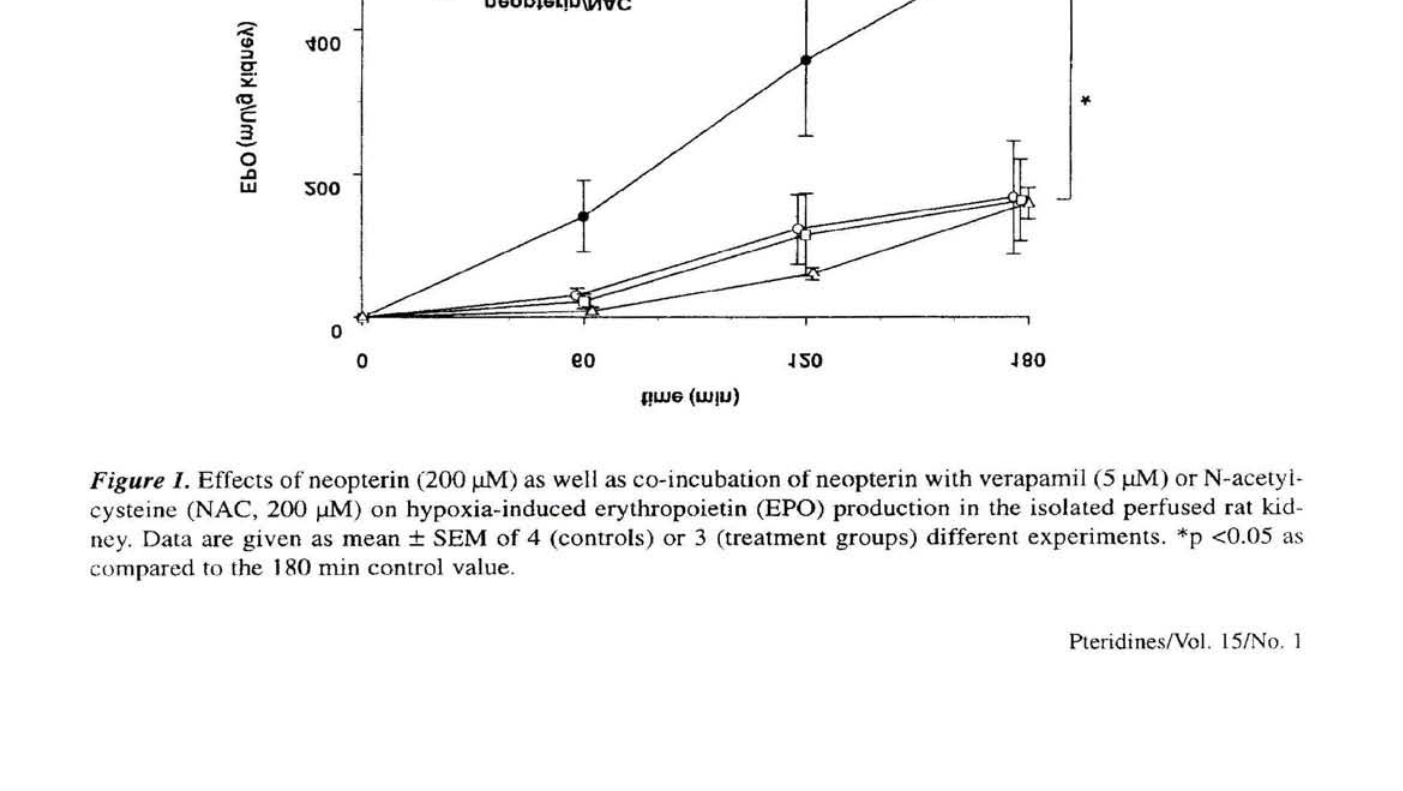
lated rat kidneys perfused hypoxically for 180 min.